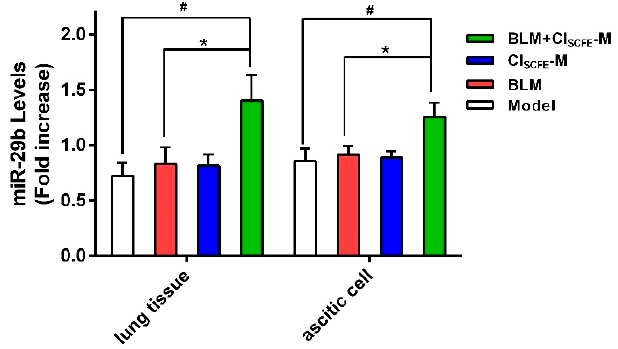
Figure 9. miR-29b expression in lung tissues and ascites cells of H22 tumor-bearing mice. Data are mean ± SEM ( n = 4). # p < 0.05 vs. model group; * p < 0.05 vs. BLM group.